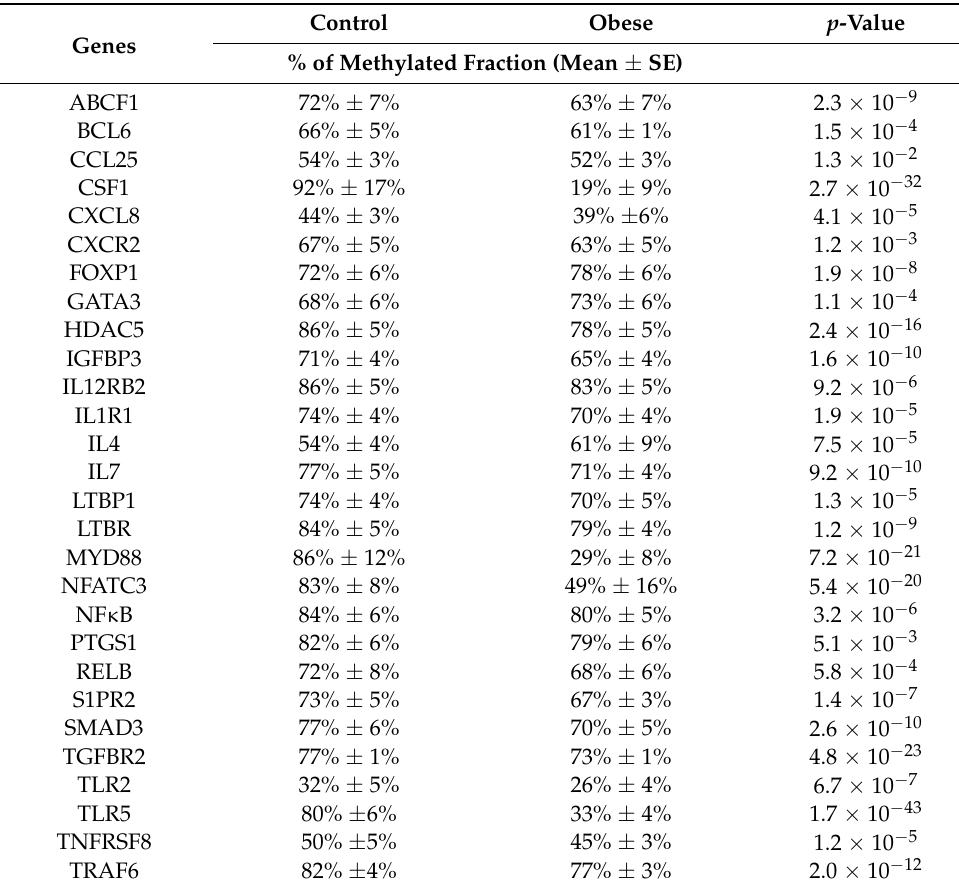
Table 4. Summary of the genes that demonstrated significant differences in DNA methylation between obese and non-obese subjects.